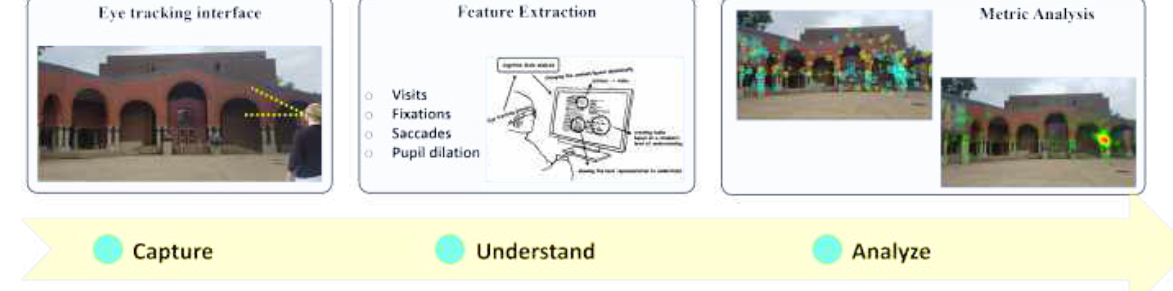
Figure 1. Overall research workflow of eye